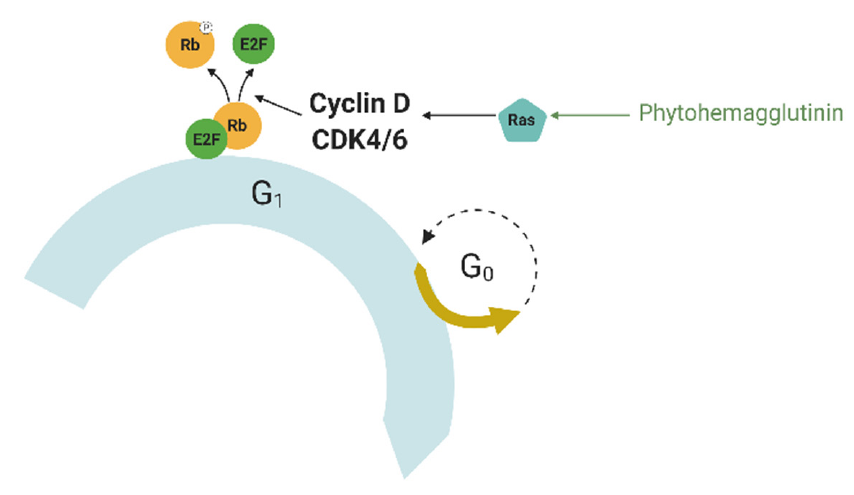
Figure 3. Mechanism of mitogen’s action on the cell cycle. The binding of a mitogen to its receptor induces the activation of the Ras protein, which leads to the activation of the expression of cyclin D, which forms a complex with Cdk4 or Cdk6 called the cyclin D-Cdk complex. This complex dissociates the Rb-E2F complex and phosphorylates the Rb protein, which controls the expression of a number of genes required for DNA replication and mitosis. Ras—rat sarcoma protein, Rb—retinoblastoma protein. Detailed explanations are provided in the